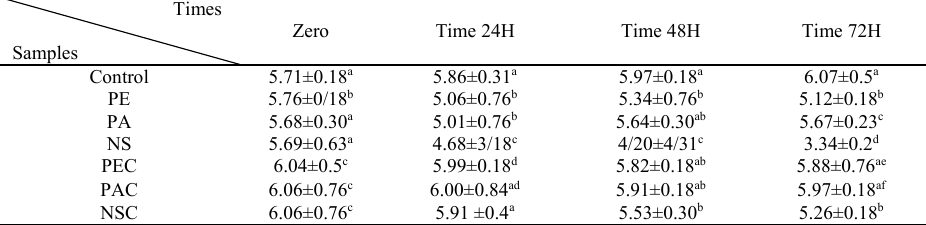
Table 2. Comparing mean and standard deviation logarithm of 7 treatments (mentioned packages) of total bacteria count in four hours (Zero, 24, 48 and 72), PE (Polyethylene), PA (Polyamide), NS (Nano-silver), PEC (Polyethylene Contaminated), PAC (Polyamide Contaminated), NSC (Nano-silver Contaminated)